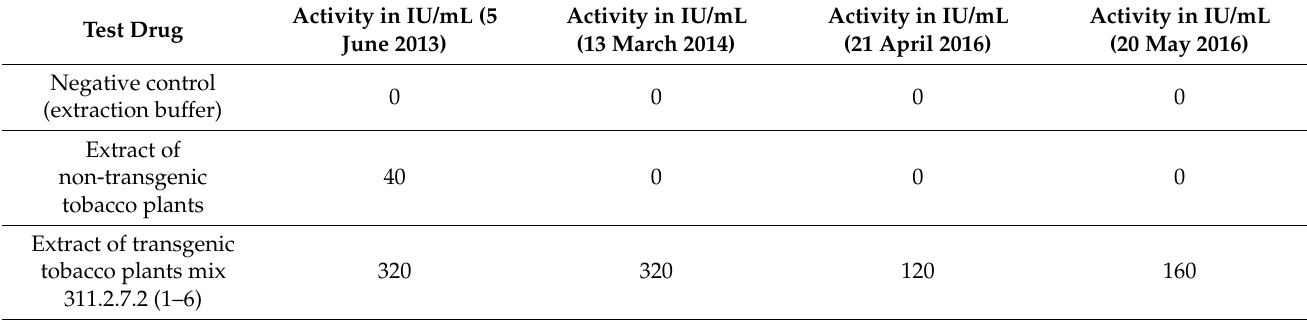
Table 2. The results of measuring the antiviral activity of interferon